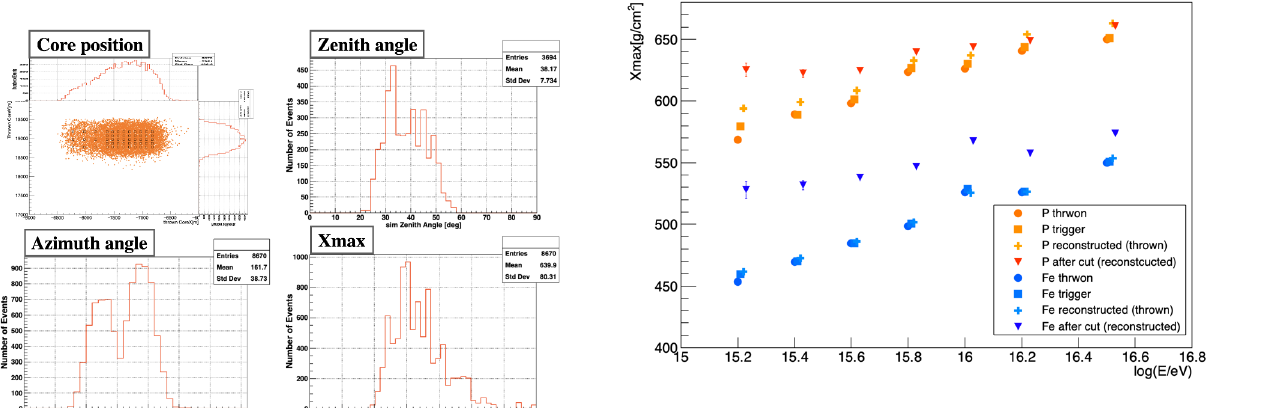
The (cid:104) X max (cid:105) bias for proton (orange) and iron(blue). These points represent thrown (cid:10) (cid:11) X true triggered (square), reconstructed max (cid:68) (cid:69) X reconstructed reconstructed with quality cuts (inverse tri- max